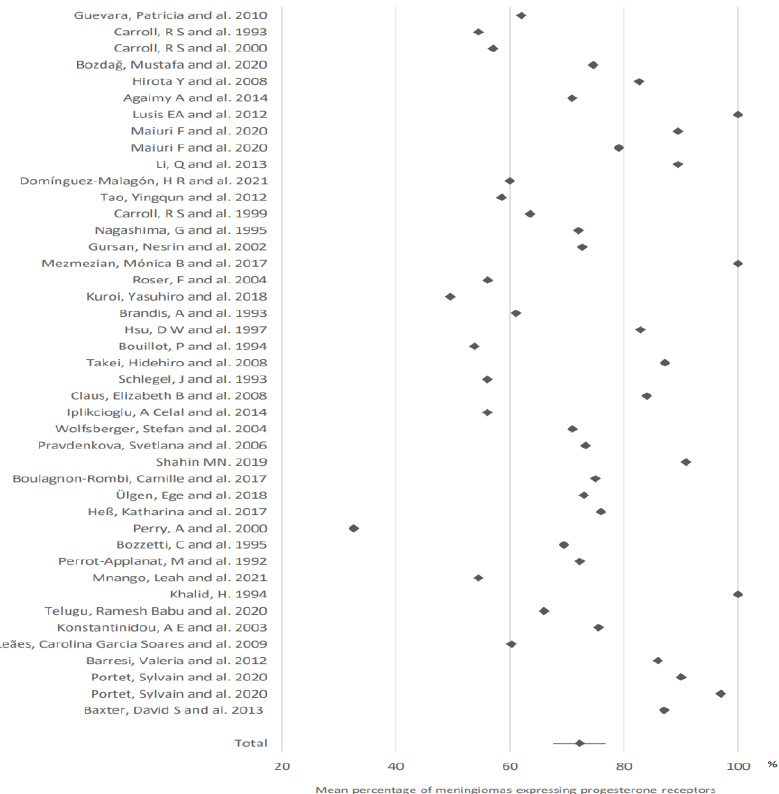
Figure 1. Expression of progesterone receptors in meningiomas. The results are expressed as a mean associated with their 95% confidence interval. Number of articles analyzed related to the topic: 44. Cancers 2023 , 15 , x FOR PEER REVIEW Number of included cases (total for all studies; minimum; maximum in each study): 3918 (11; 588). Twenty-six articles allowed the study of the expression of estrogen receptors in men- ingiomas (Figure 2): these receptors were expressed in 11.3% of cases (95% CI: 5.9 – 16.7).